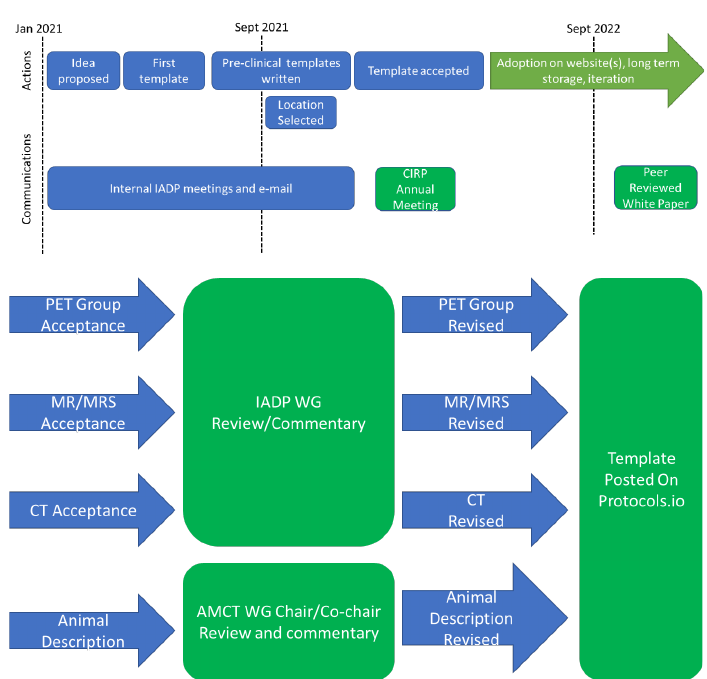
Figure 1. The timeline and workflow for development of Pre-clinical imaging workflows. ( Top ) The linear timeline from the proposal of the idea, drafting of the first template (MRI), and then extension and validation by other groups. ( Bottom ) The high-level workflow for production, review, and re- vision of pre-clinical imaging templates. Abbreviations: CIRP: Co-clinical Imaging Research Pro- gram; IADP: Image Acquisition and Data Processing; WG: working group; MRS: magnetic reso- nance spectroscopy; PET: positron emission tomography; CT: computerized tomography.